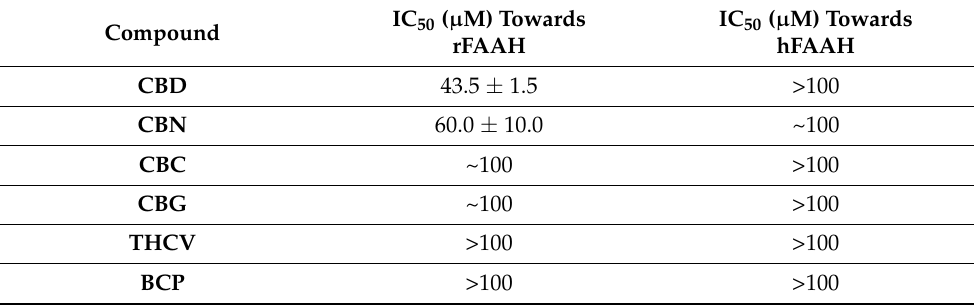
Table 4. Inhibition of rFAAH and hFAAH by cannabis-derived compounds.